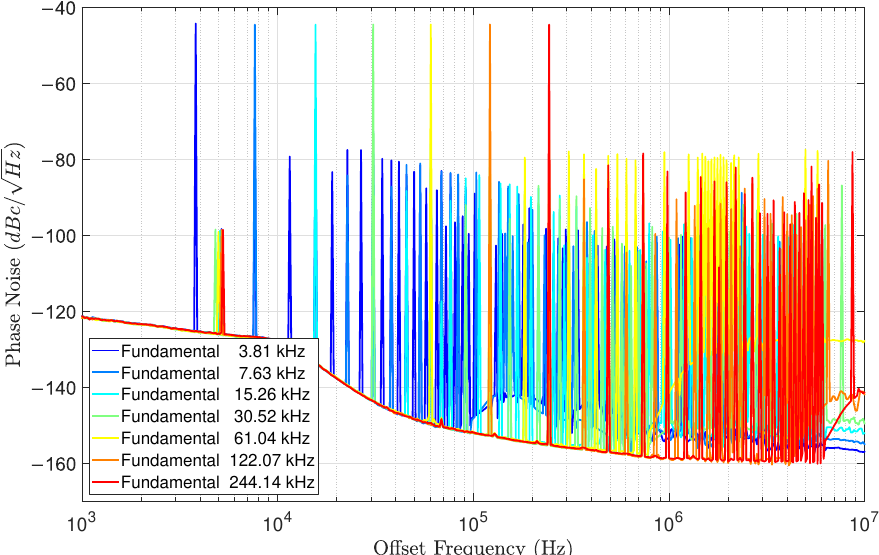
Figure 2. The phase noise spectra of the sinewave modulated test signals generated using the AD9910 DDS for various fundamental frequencies. Reprinted with permission from ref. [7]; Copyright 2021 IEEE.